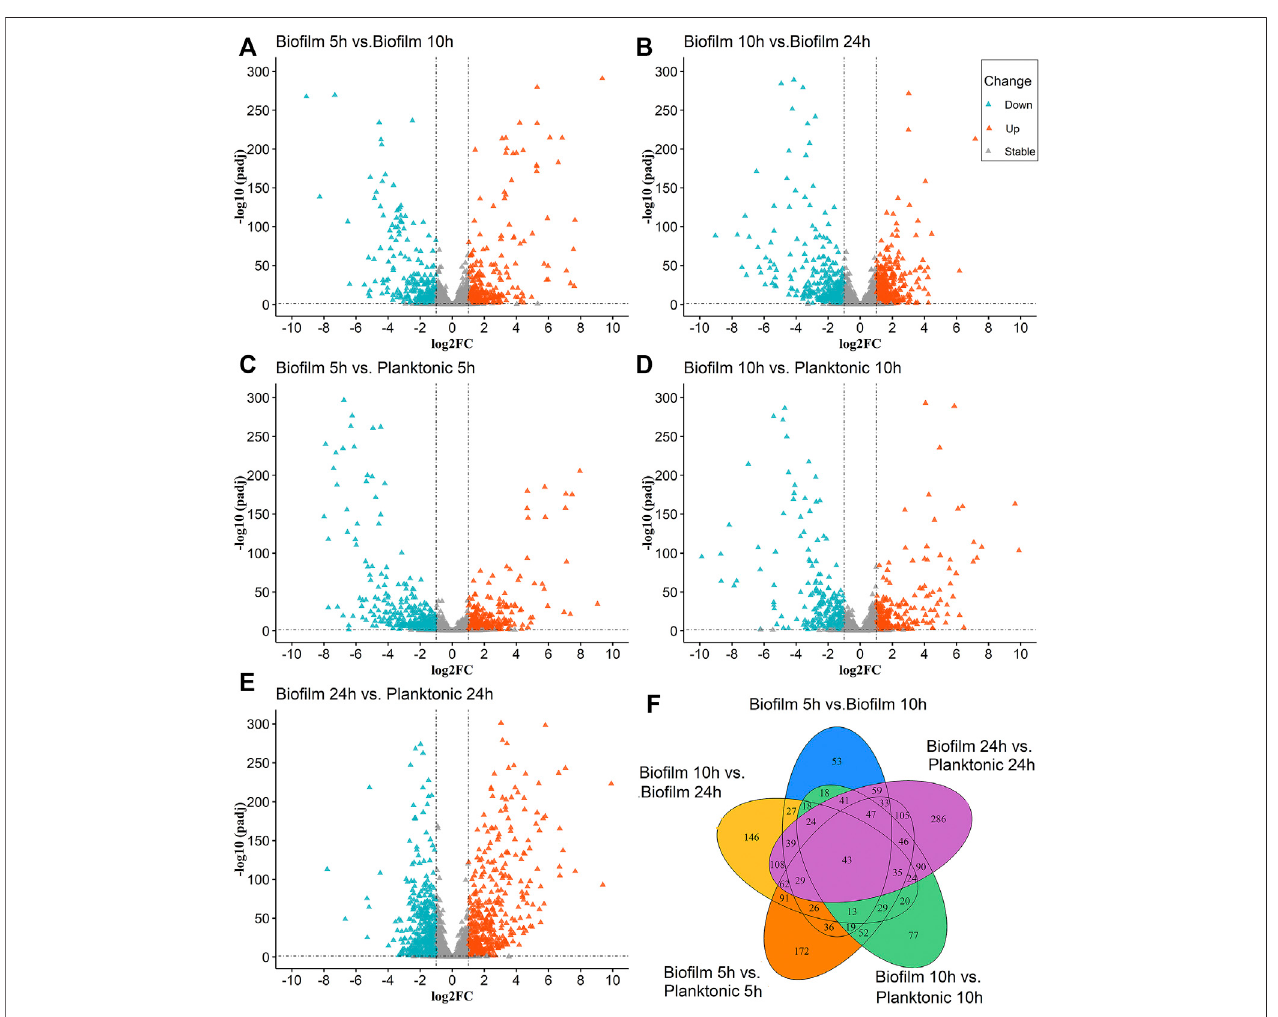
FIGURE1| TheVolcanoandVenndiagramsforthedifferentialanalysisofthebio fi lmandplanktonicbacteria; (A – E) indicatedthedifferentialanalysisfor fi vegroups (bio fi lm 5 h vs. bio fi lm 10 h, bio fi lm 10 h vs. bio fi lm 24 h, bio fi lm 5 h vs. planktonic 5 h, bio fi lm 10 h vs. planktonic 10 h and the bio fi lm 24 h planktonic 24 h), which contained up-regulated DEGs 281, 382, 399, 271, 506 and down-regulated DEGs 250,356, 451, 328, 574, respectively. In (A – E) , the “ triangles ” represent the genes, thecolor “ azure ” isasigni fi cantlydownregulatedgene,thecolor “ orange ” isasigni fi cantlyupregulatedgene,andthecolor “ gray ” isanon-signi fi cantgene. (F) Venn diagram for overlaps of DEGs in (A – E)